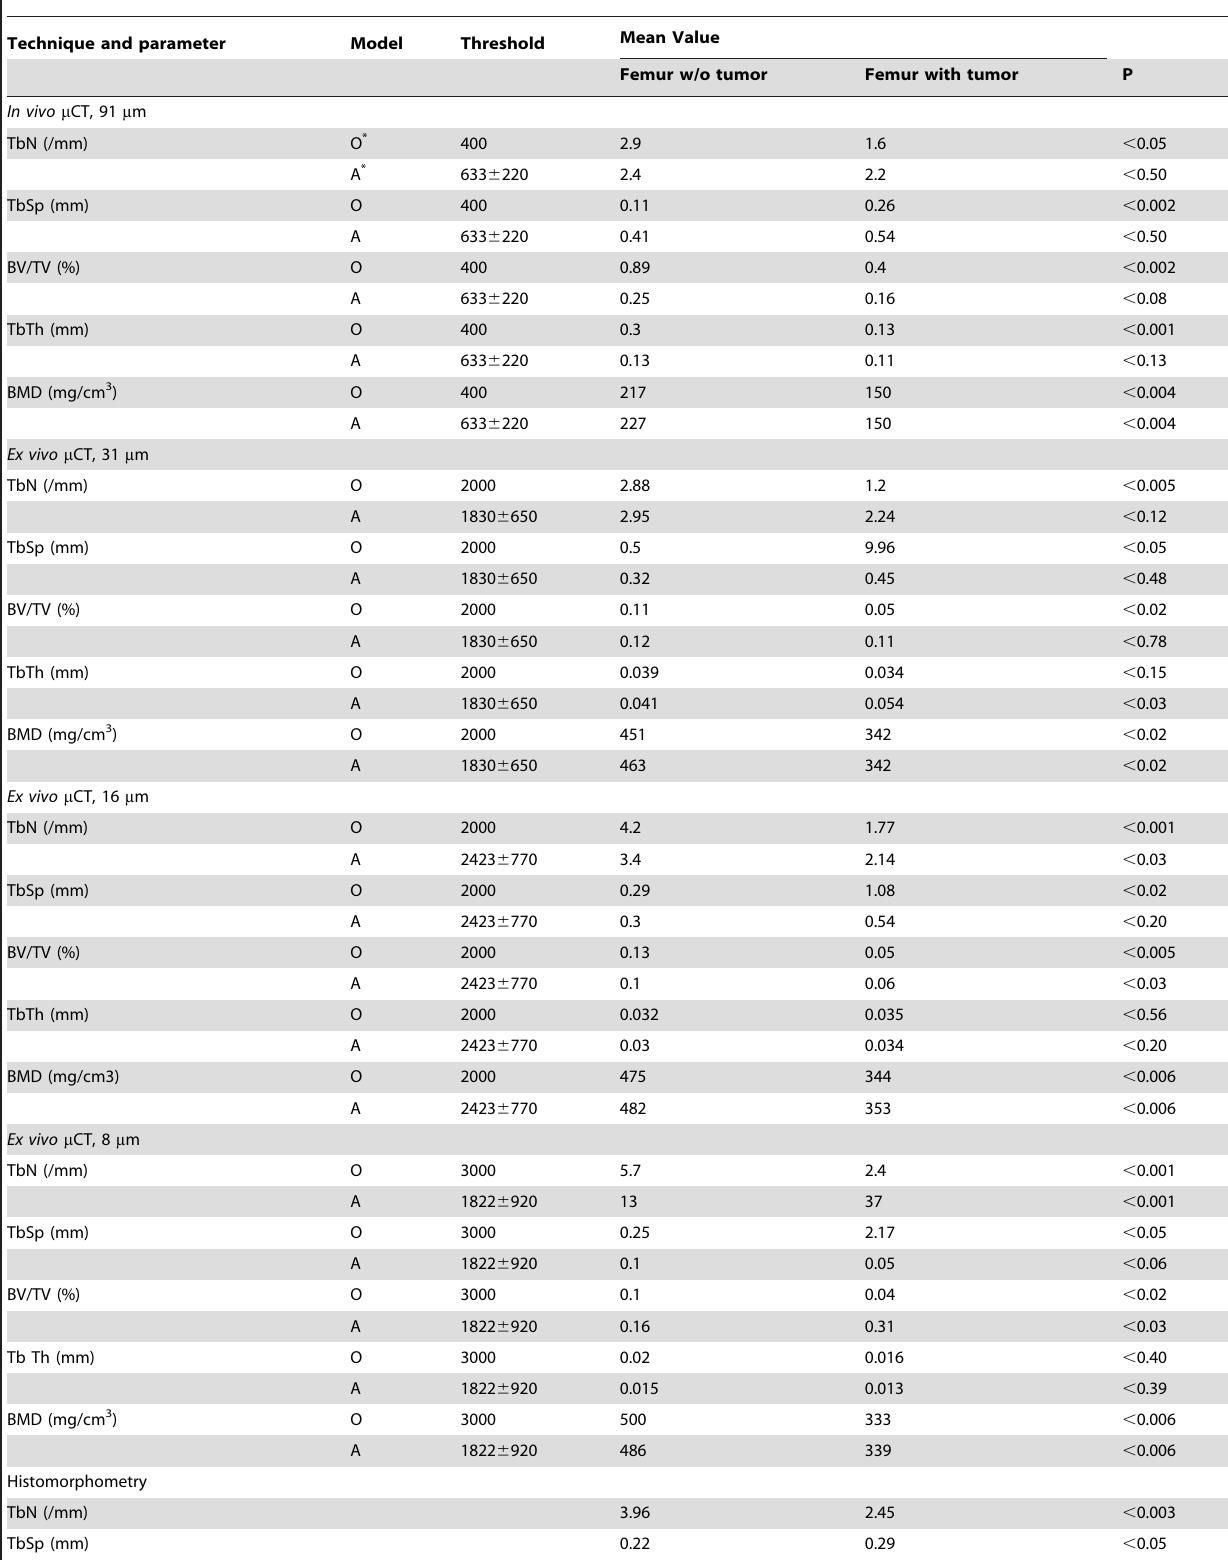
Table 3. Metaphyseal bone structural parameters determined by in vivo m CT, ex vivo specimen m CT, and bone histomorphometry 10 weeks after tumor